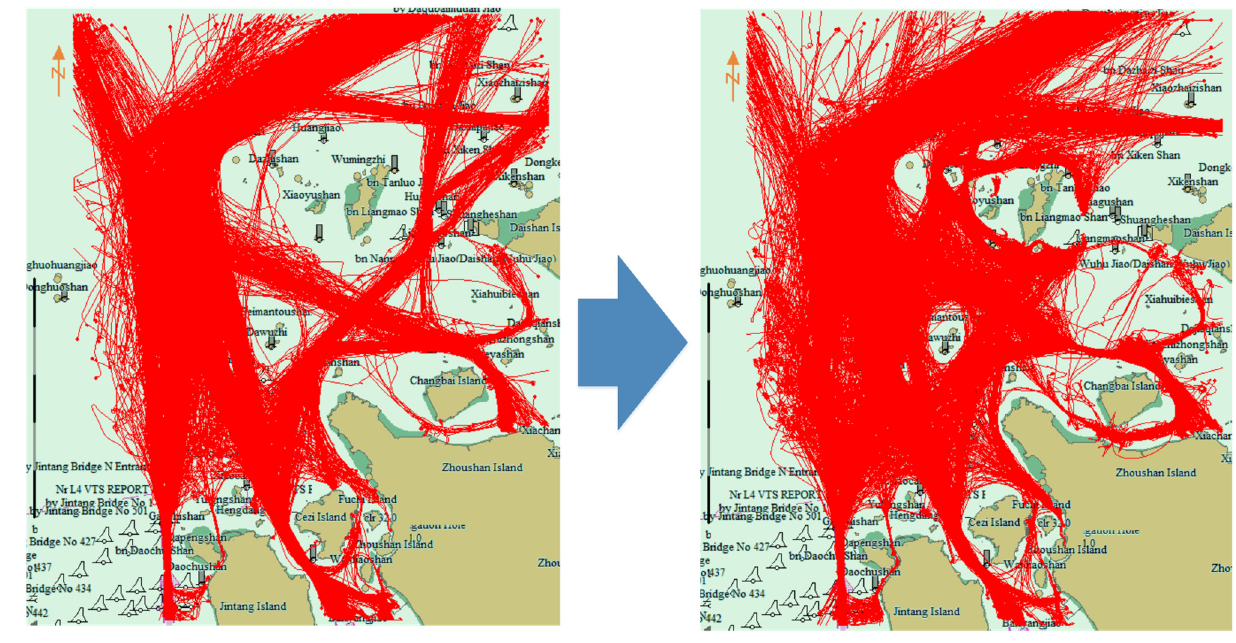
Figure 8. Traffic flow before and after prohibition of navigation. Red lines are the ship trajectories. Left picture is the traffic flow before the construction of Yushan bridge, right picture is the traffic flow after the construction of Yushan bridge. The traffic flow at Yushan Bridge was cut off after construction.